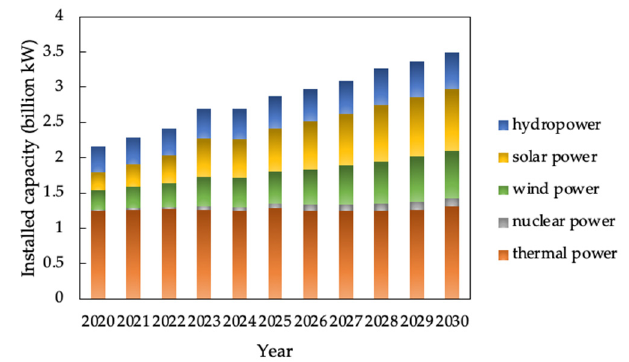
Figure 5. Installed capacity of various energy sources in 2025 and 2030 under normal conditions.